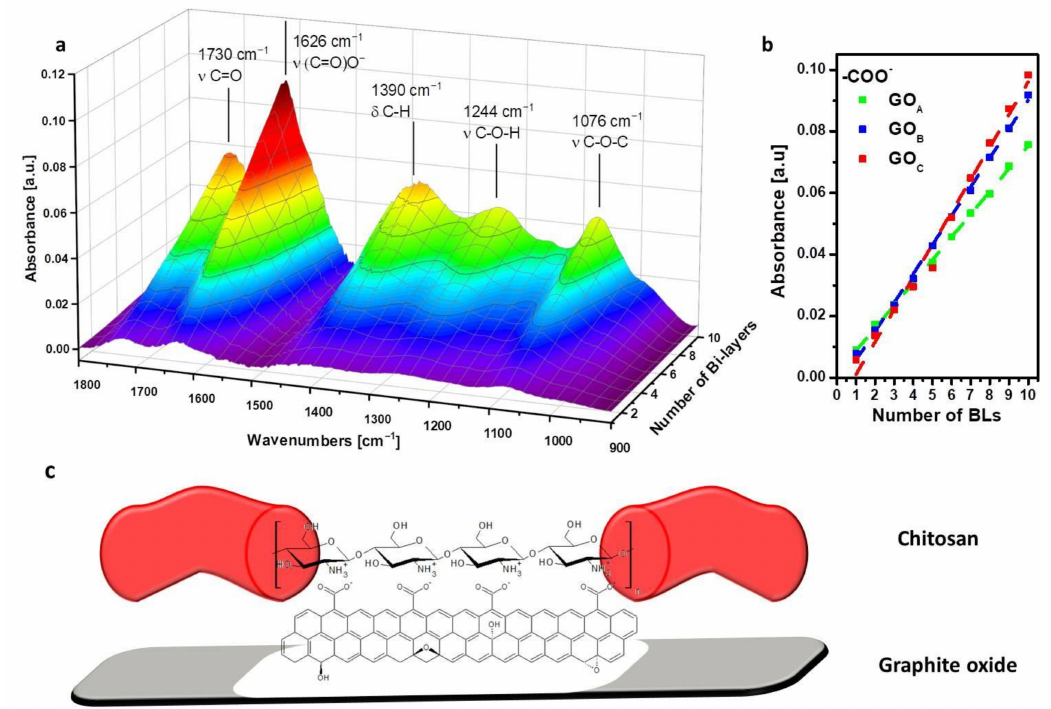
Figure 2. FTIR LbL growth of CHIT/GO A assembly conducted on a silicon wafer as substrate ( a ), 1626 cm − 1 plot as function of deposited bi-layer (BL) for all the under-study assemblies ( b ), CHIT/GOx ( c )